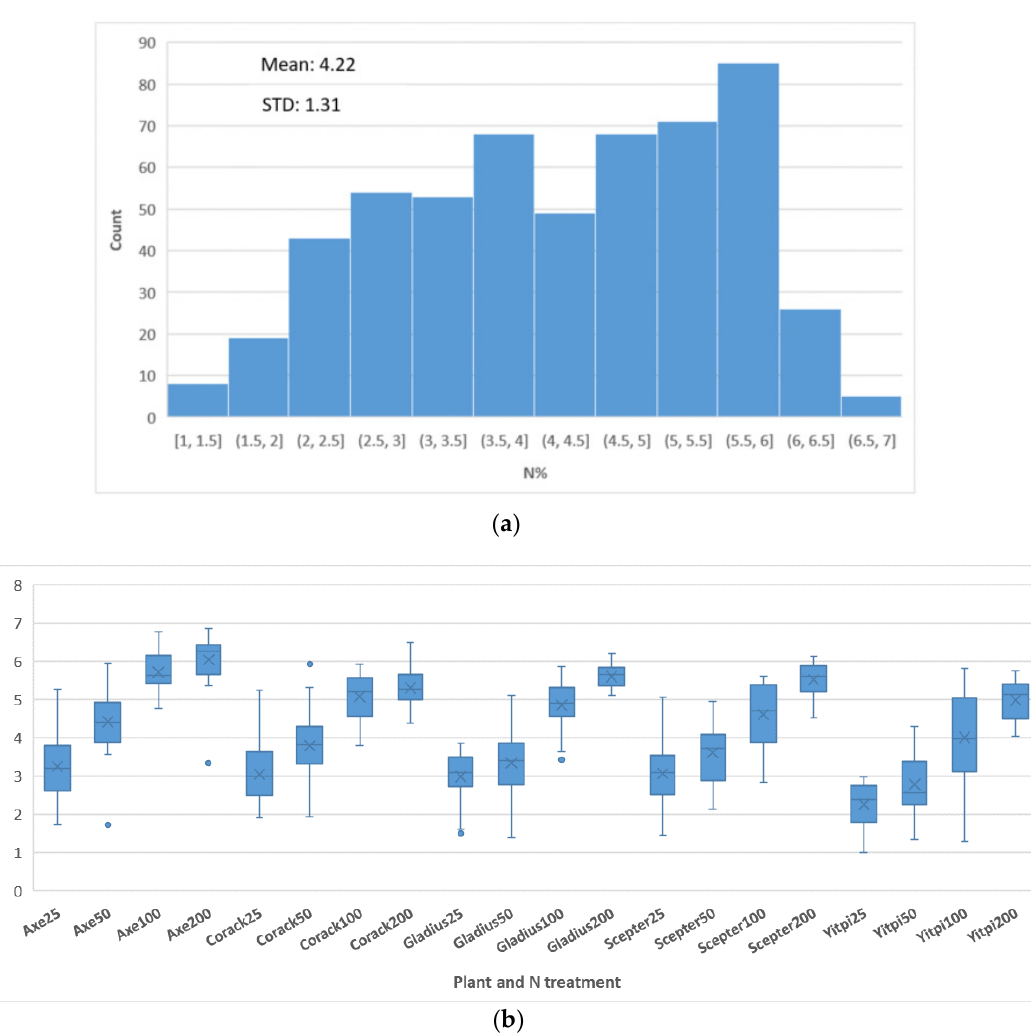
Figure A3. Distributions of reference N% values ( a ) Distribution of all N% values. The mean N value is 4.22% with a standard deviation of 1.31%. The distribution has the highest peak in the range of 5.5% to 6.0%. ( b ) Box & whisker plot of the N% values according to the plants and N treatments.